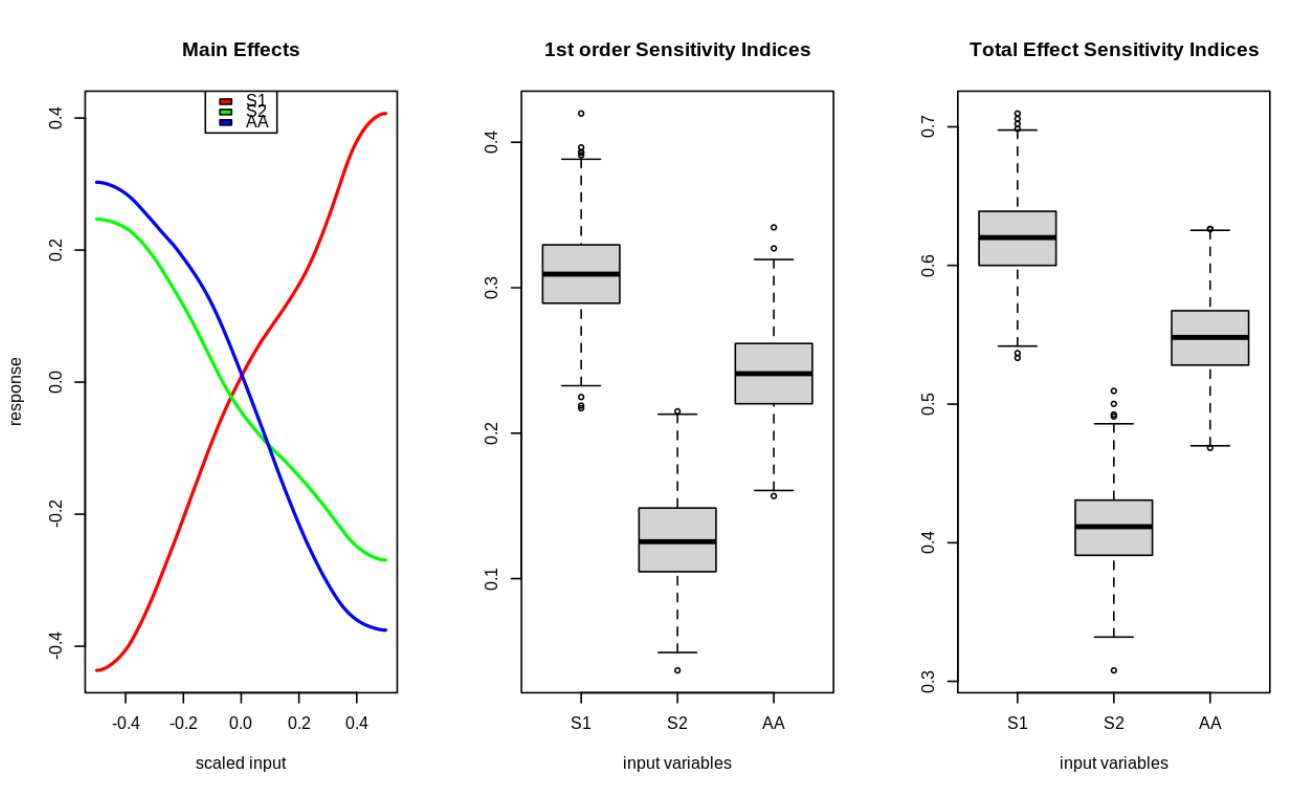
Figure 7. The estimated main effects, 1st and 2nd order sensitivity indices of the parameters in the traffic jam scenario as discussed in Table 3.